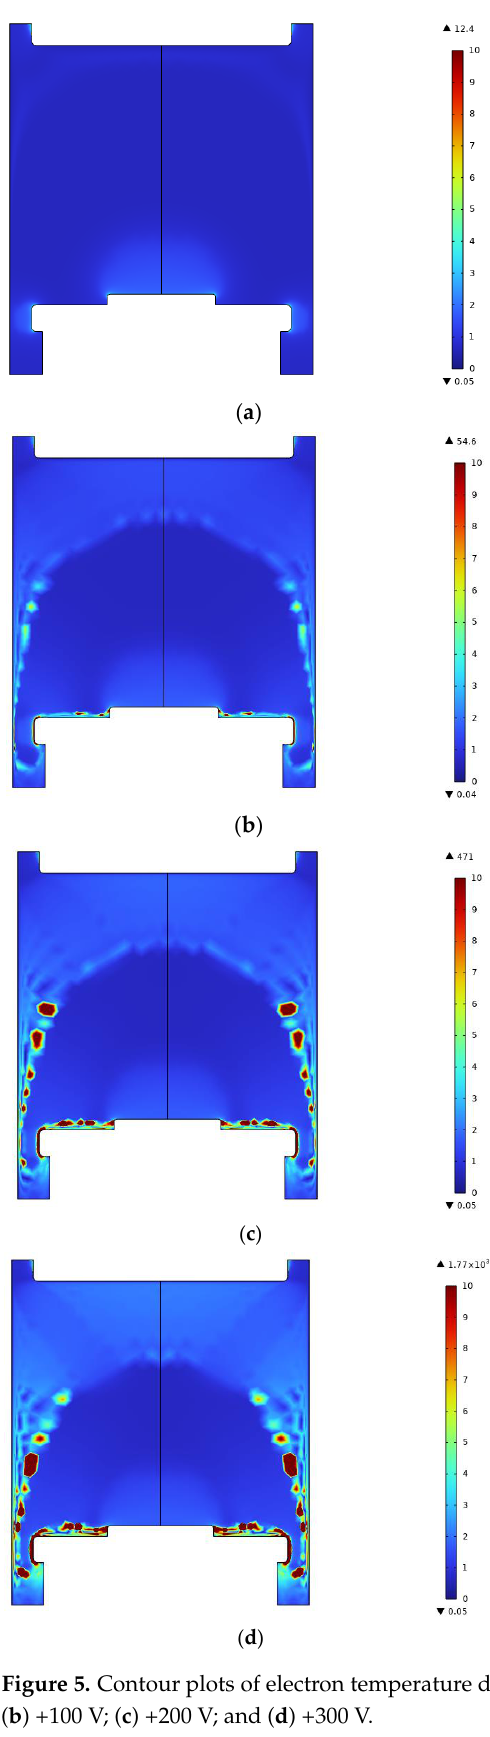
Figure 5. Contour plots of electron temperature distribution in the deposition chamber (eV). ( a ) 0 V; V; ( b ) +100 V; ( c ) +200 V; and ( d ) +300 V. ( b ) +100 V; ( c ) +200 V; and ( d ) +300